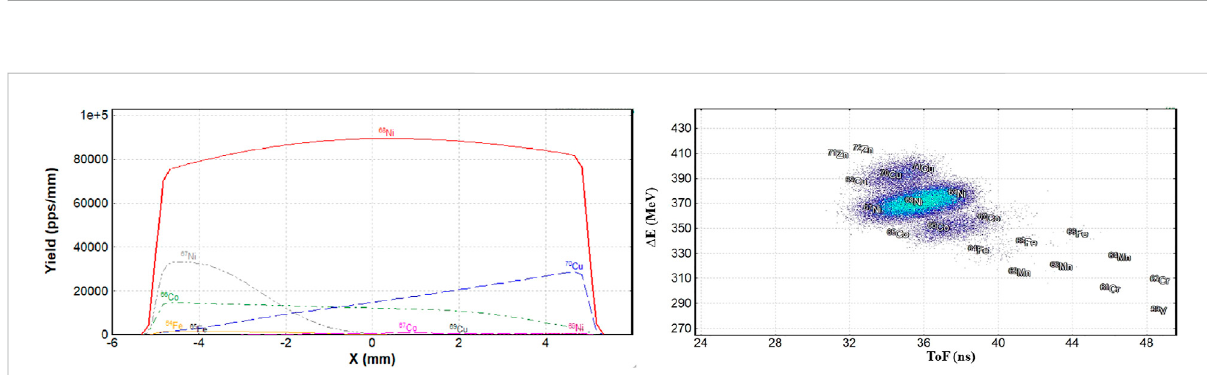
FIGURE 10 Left: simulated spatial distribution at the exit of the fragment separator on the horizontal direction and simulated Δ E-TOF (right), in the case of 70 Zn 30+ primary beam at 40 AMeV and for a tuning of the fragment separator maximizing the 68 Ni production. For the sake of clarity, only the main contaminants are shown in the spatial distribution